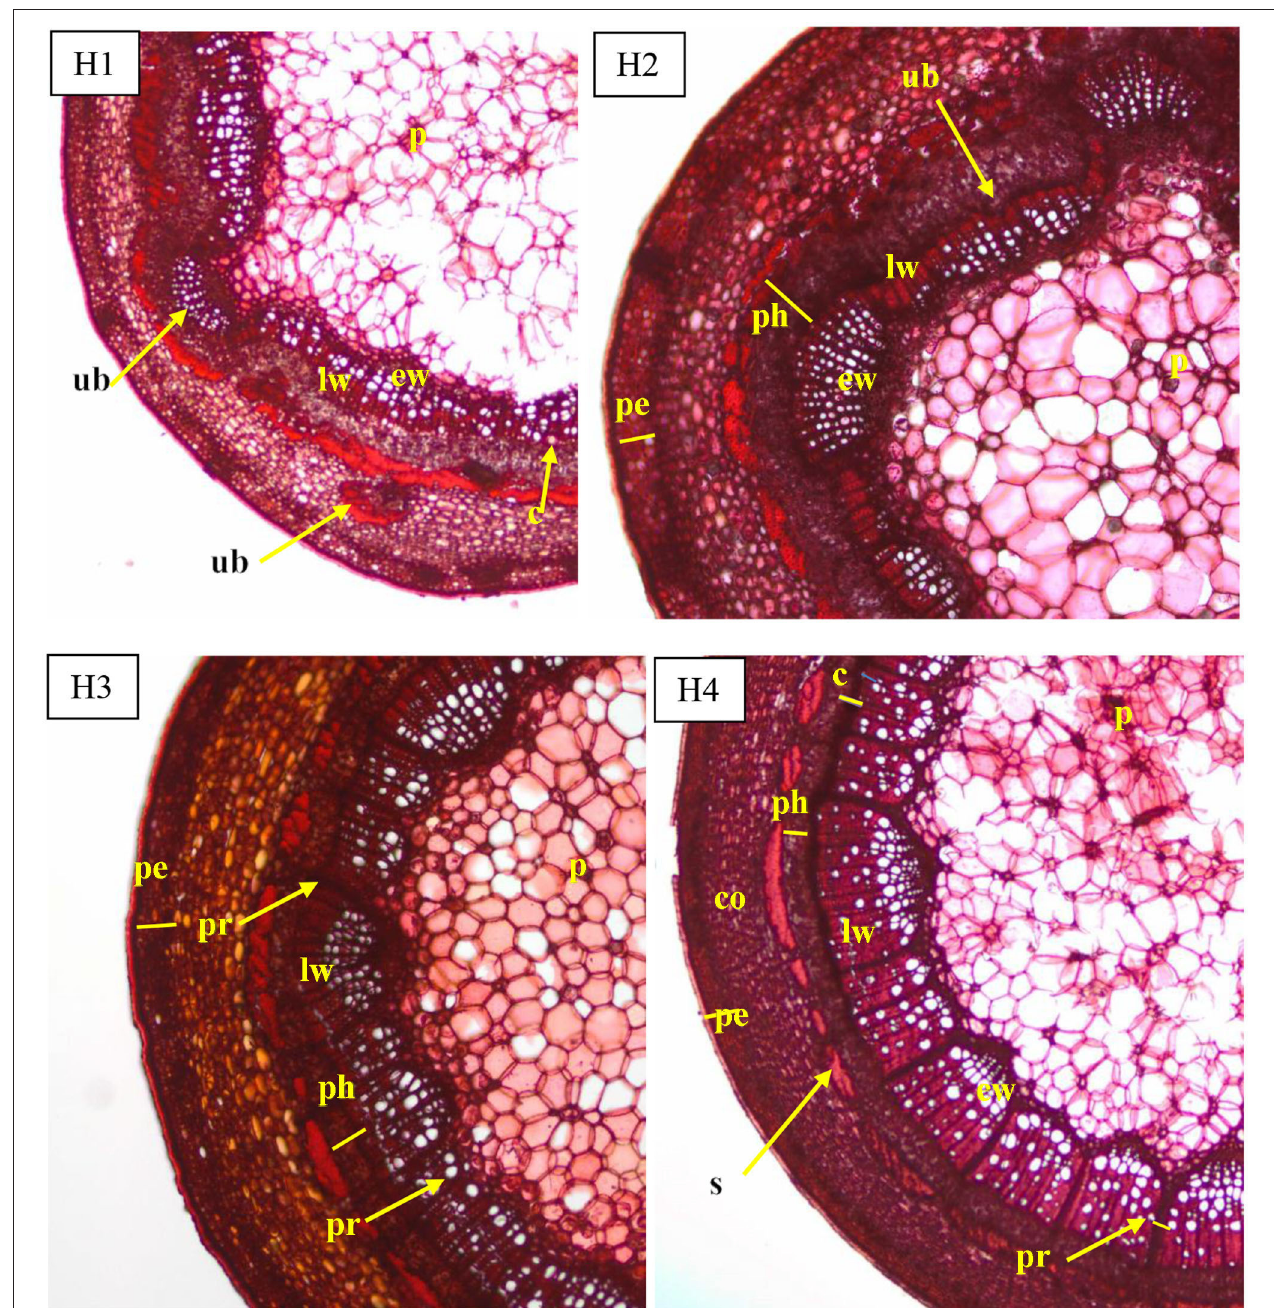
FIGURE 2 | Transverse sections of the shoots before rooting in Rosa “Hurdal” in four phenological stages in BBCH scale (Meier et al., 2009): H1 − 54,504 (flower buds still closed); H2 − 69,605 (full flowering; at least 50% of flowers open); H3 − 69,629 (end of flowering of the second-order stem—all petals have fallen); H4 − 70,701 [fruit set: beginning of hip (berry) growth on the main stem]. Designation of signs: ub, unregular vascular bundles; c, cambium; co, cortex; pe, periderm; ph, phloem; p, pith; pr, pith rays; s, sclerenchyma; ew, earlywood; lw, latewood.